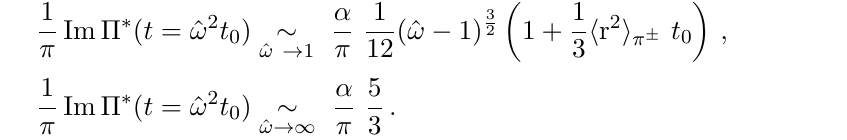
units of the skeleton spectral function 1 π